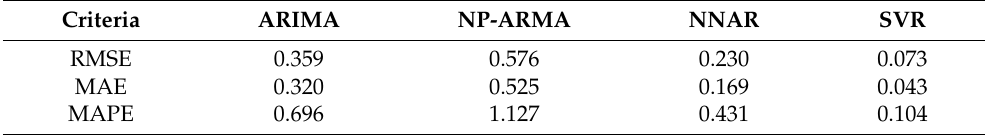
Table 11. The error metrics using the COVID-19 dataset taken from